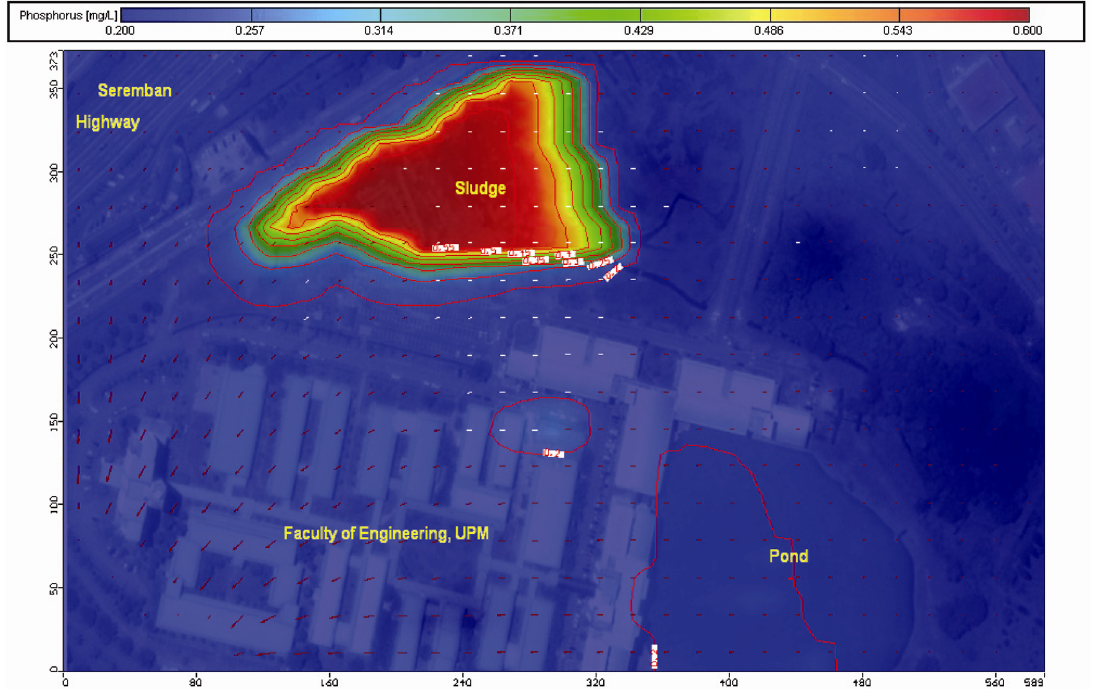
Fig. 5. Result of simulation of contamination migration in Layer No. 1 after 50 years